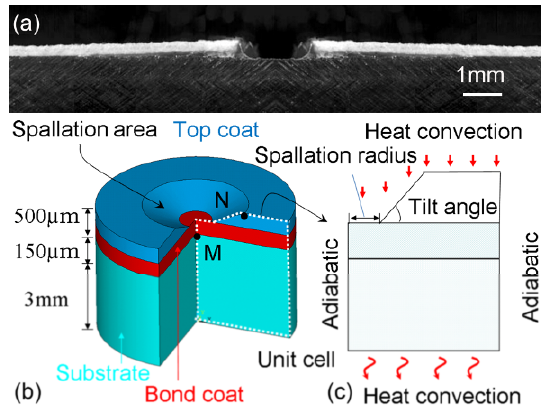
Fig. 1 Developed model used in the finite element simulation: (a) optical photomicrographs of spalled TBCs [32]; (b) the cylinder like model with a spallation area in ceramic top-coat; (c) the simplified 2D axisymmetric analytical model. Table 1 Parameters of the finite element model used in